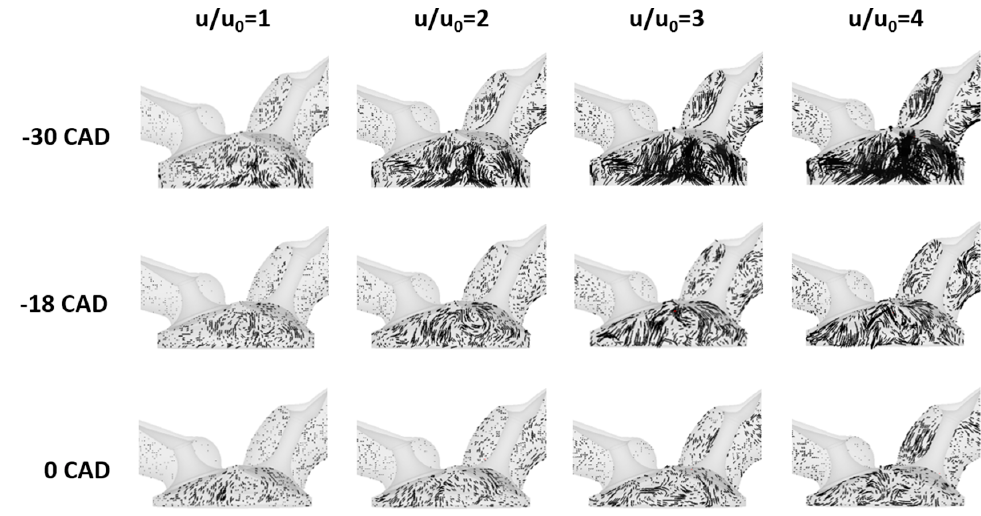
Figure 3. Evolution of different initial velocity fields.